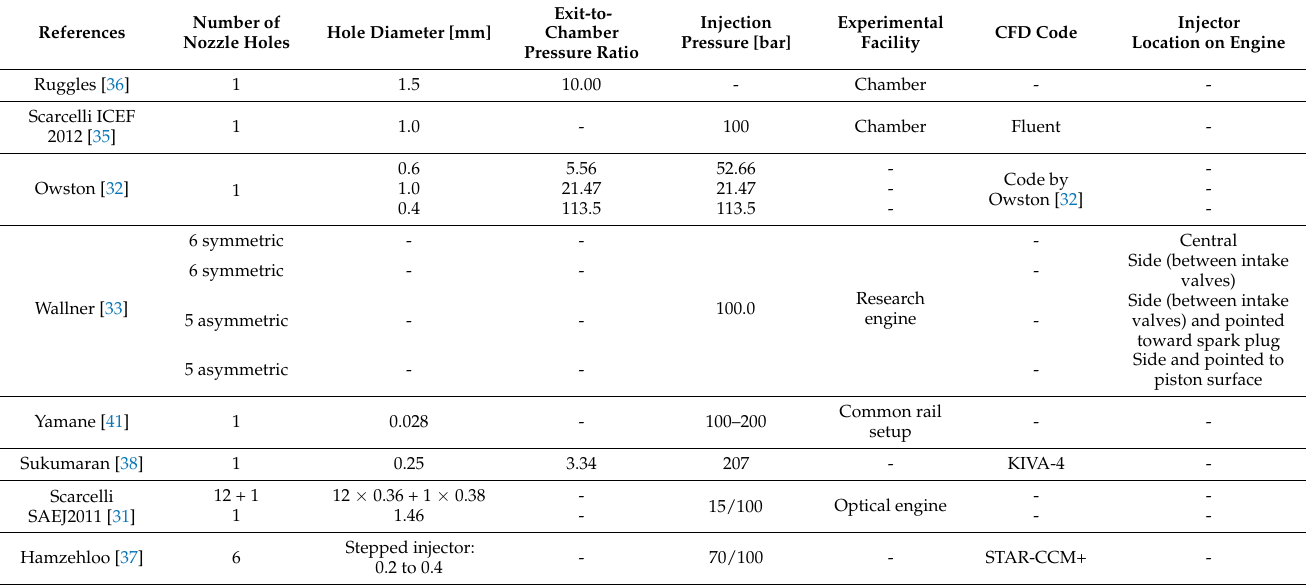
Table 2. Summary of the main experimental and numerical analyses of gaseous direct